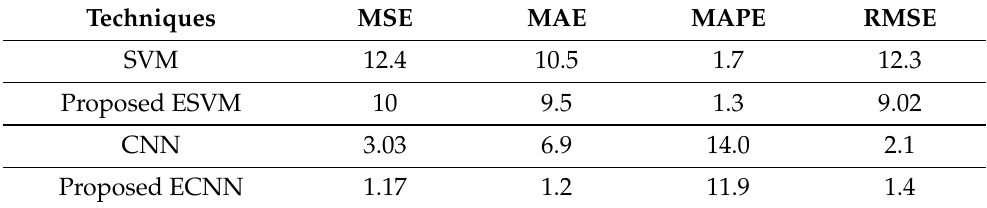
Figure 12. Error values of different techniques for four months load forecasting. Table 2. Error values (%).